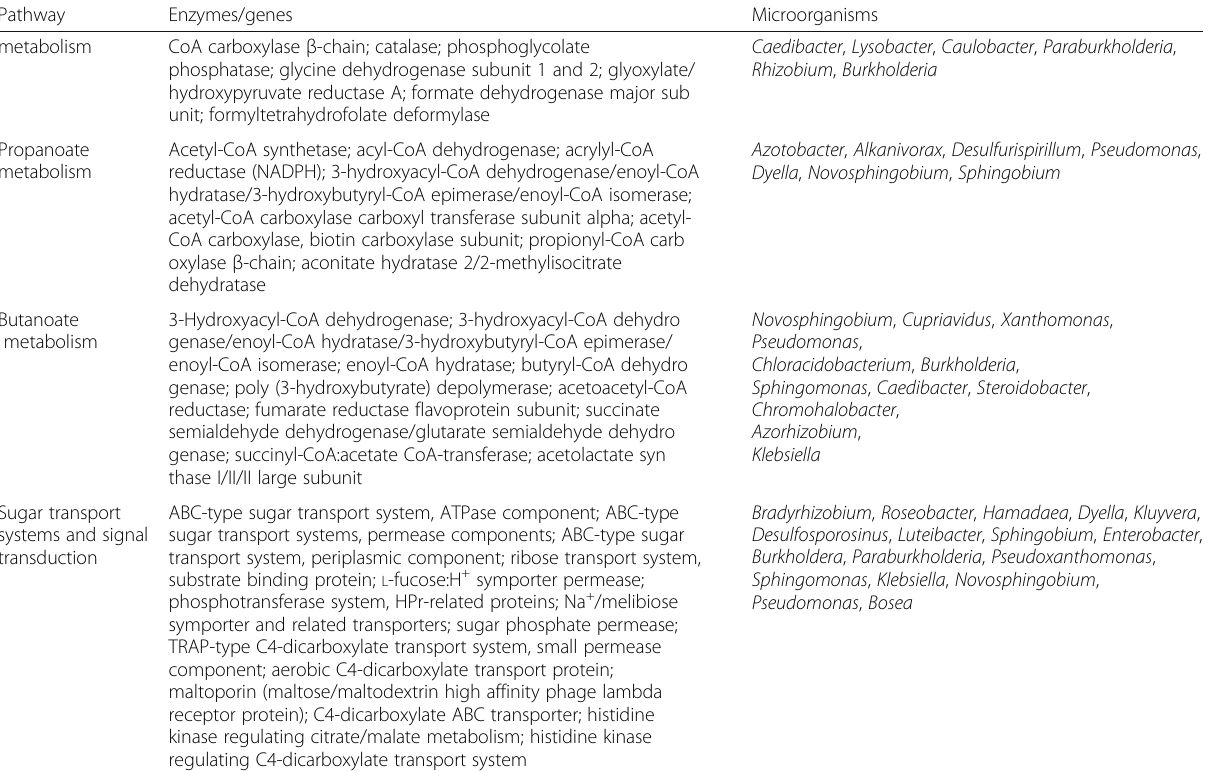
Table 1 List of the enzymes/genes and microorganisms detected in AB1 microcosm involved in diverse metabolism of carbohydrates